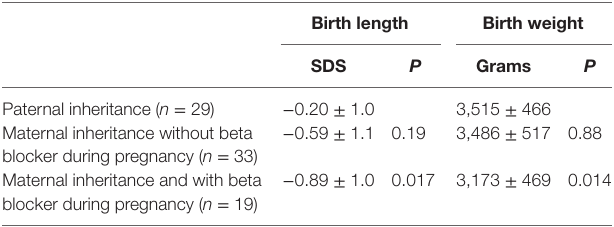
TaBle 2 | Distributions (mean ± SD) of birth length [in standard deviation scores (SDS)] and birth weight in patients with long QT syndrome 1 due to paternally or maternally inherited KCNQ1